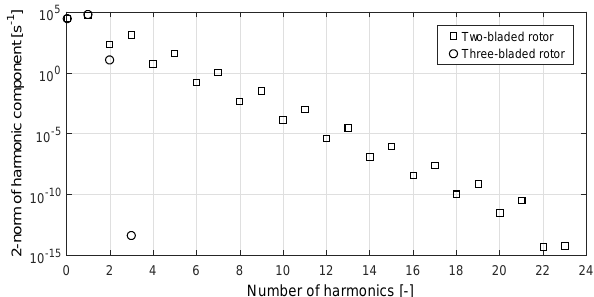
Figure 3. The 2-norms of the Fourier components of the system matrices for the two- and three-bladed simple models of the DTU 10MW